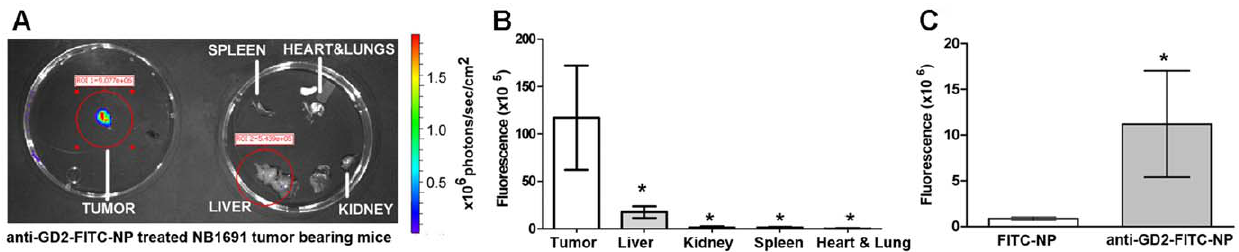
Figure 2. Targeting of neuroblastoma by systemically administered anti-GD 2 conjugated nanoparticles. (A) Systemic administration through lateral tail injection of FITC-anti-GD 2 -NPs (1 mg/ml) resulted in targeted delivery of FITC dye predominantly to tumors (indicated by fluorescence intensity color map generated from scans using IVIS instrumentation). (B) FITC-anti-GD 2 -NP-treated organs have significantly less fluorescence than isolated tumors (*p , 0.05, n=4 2 5) and (C) FITC-anti-GD 2 -NP treated tumors showed significantly greater presence of FITC dye relative to FITC-NP treated tumors (*p , 0.05, n=4 2 5).